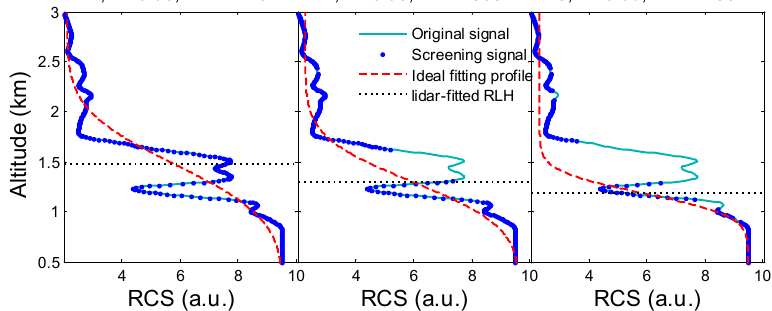
Figure 3. RLH determined by the improved method with Lidar-measured RCS at 02:48, 30 November 2013 (CST). The signal corresponds to the black dotted line in Figure 2.